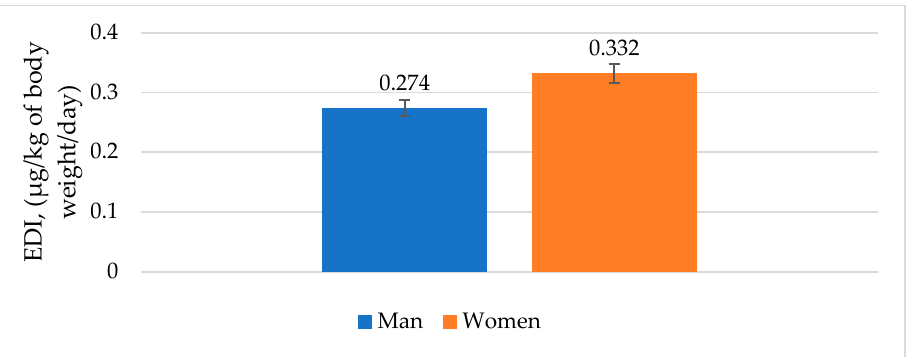
Figure 1. Estimated daily intake (EDI) through freshwater fish consumption by men and women in Europe.